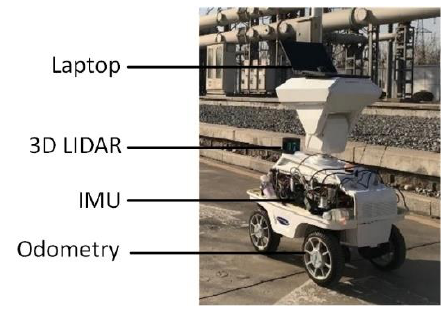
Figure 4. The mobile robot (SmartGuard) for experiments.